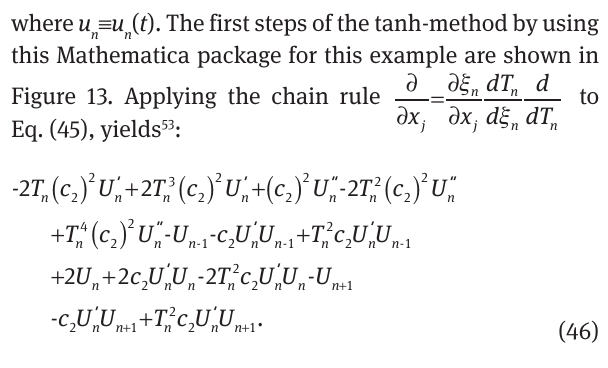
52 The previous scalar Toda equation in subsection 1.3 was with two continuous variables ( x , t